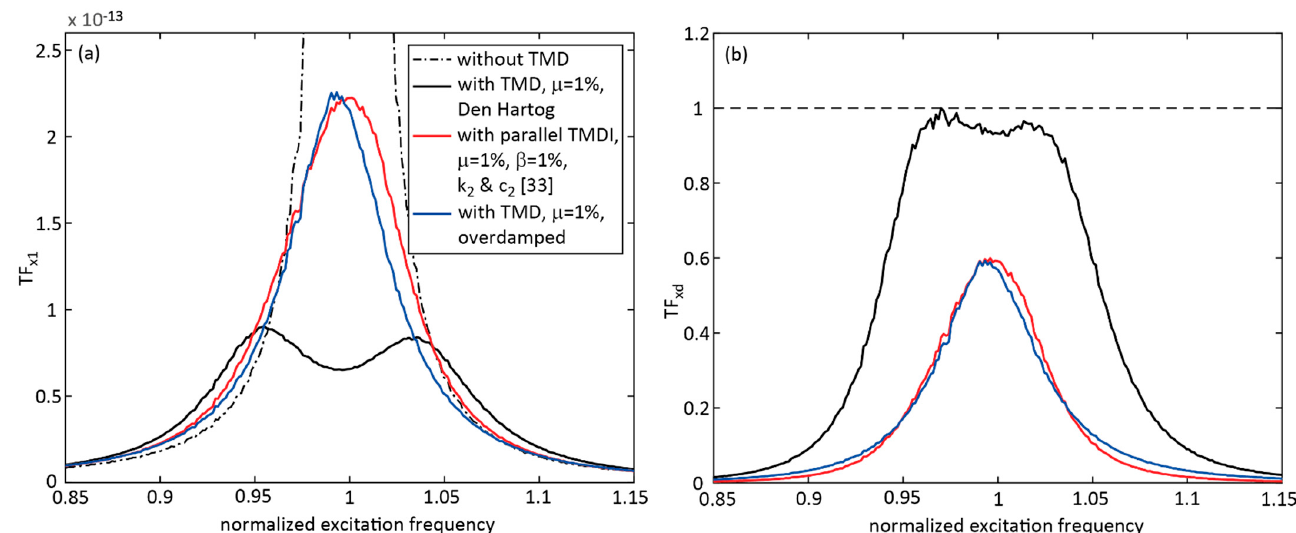
Figure 5. Performances of TMDI with inerter in parallel to stiffness and viscous damper ( µ = 1%, β = 1%, parameters as in [33]), TMD ( µ = 1%, Den Hartog parameters) and overdamped TMD ( µ = 1%) for random excitation: ( a ) primary structure normalized displacement response and ( b ) normalized damper relative motion